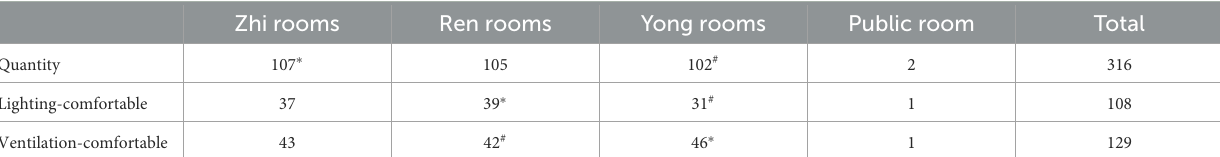
TABLE 3 Statistics of nature unit